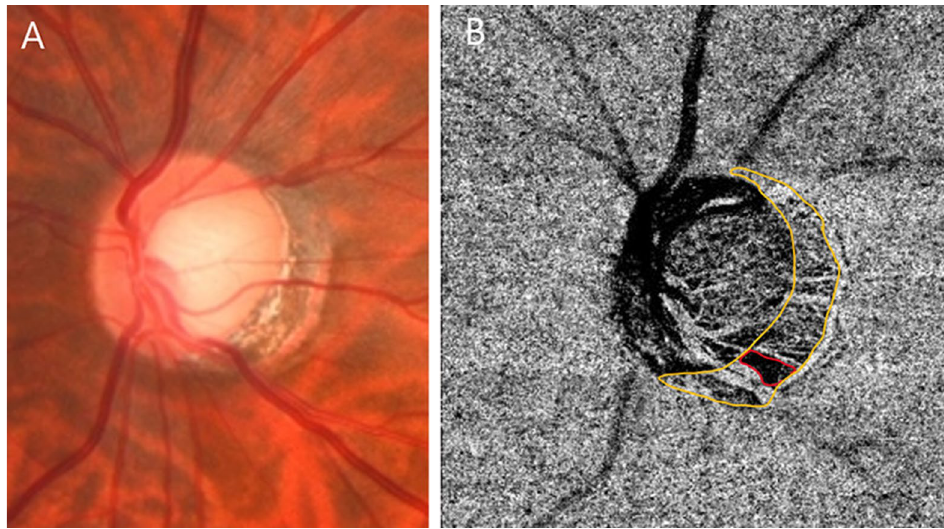
Figure 5. Definitiion of microvascular dropout (MvD). MvD was defined as focal, sectoral complete loss of choriocapillaris within the visible microvascular network. MvD in the left eye. Sectoral complete loss of choriocapillaris (red line) in peripapillay atrophy (yellow